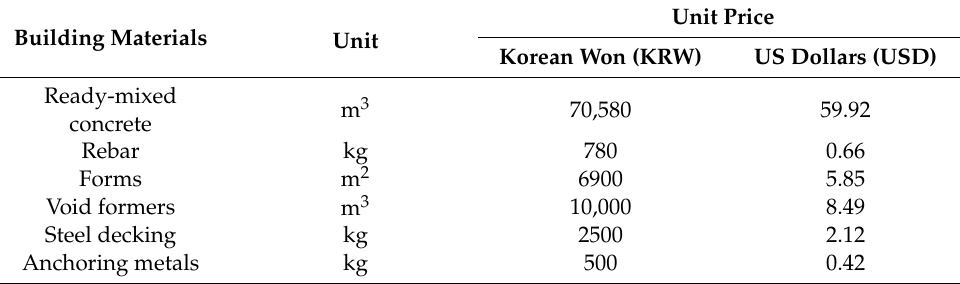
Table 5. The list of unit price of the building materials [39].